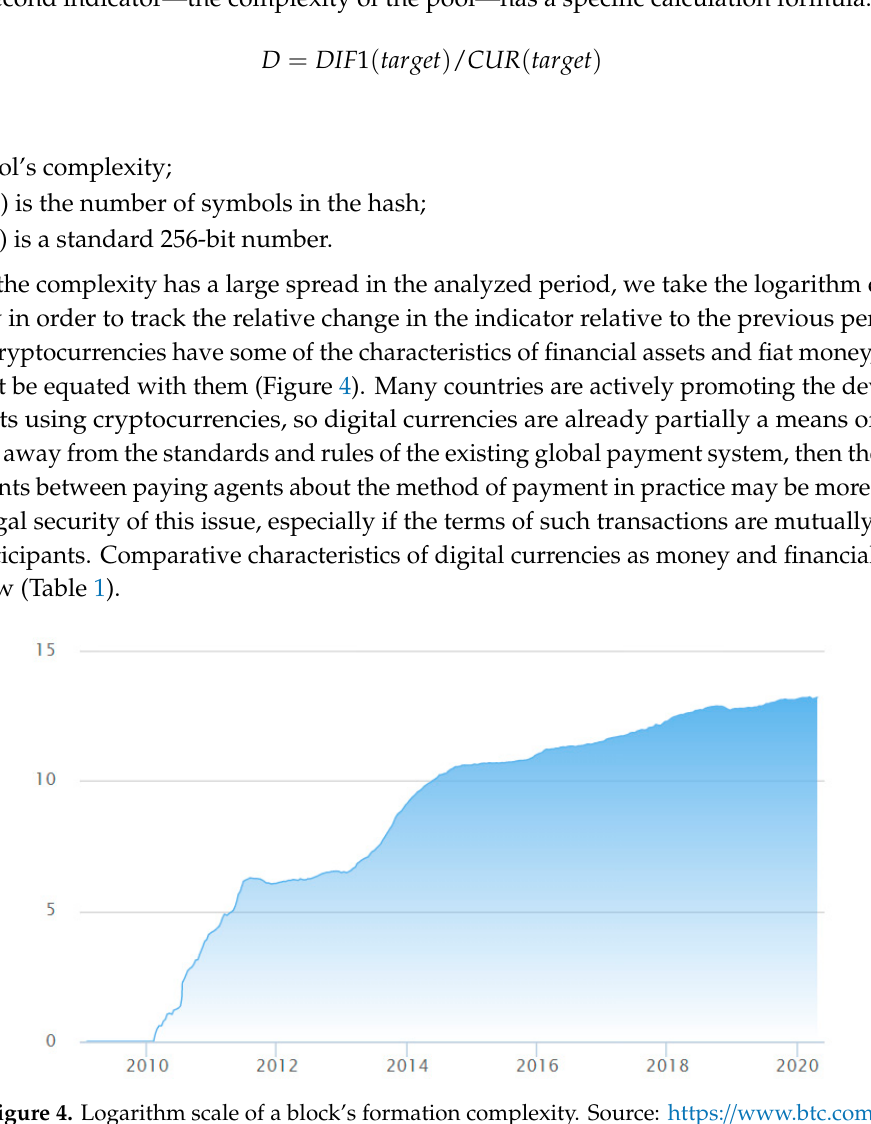
Figure 3. Bitcoin hashrate, EH/s. Source: https://www.blockchain.com.